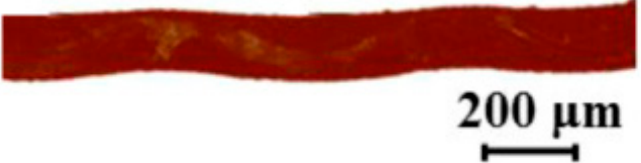
Figure 8. Cross section of swollen AMX-Sb membrane. Adapted from [20].